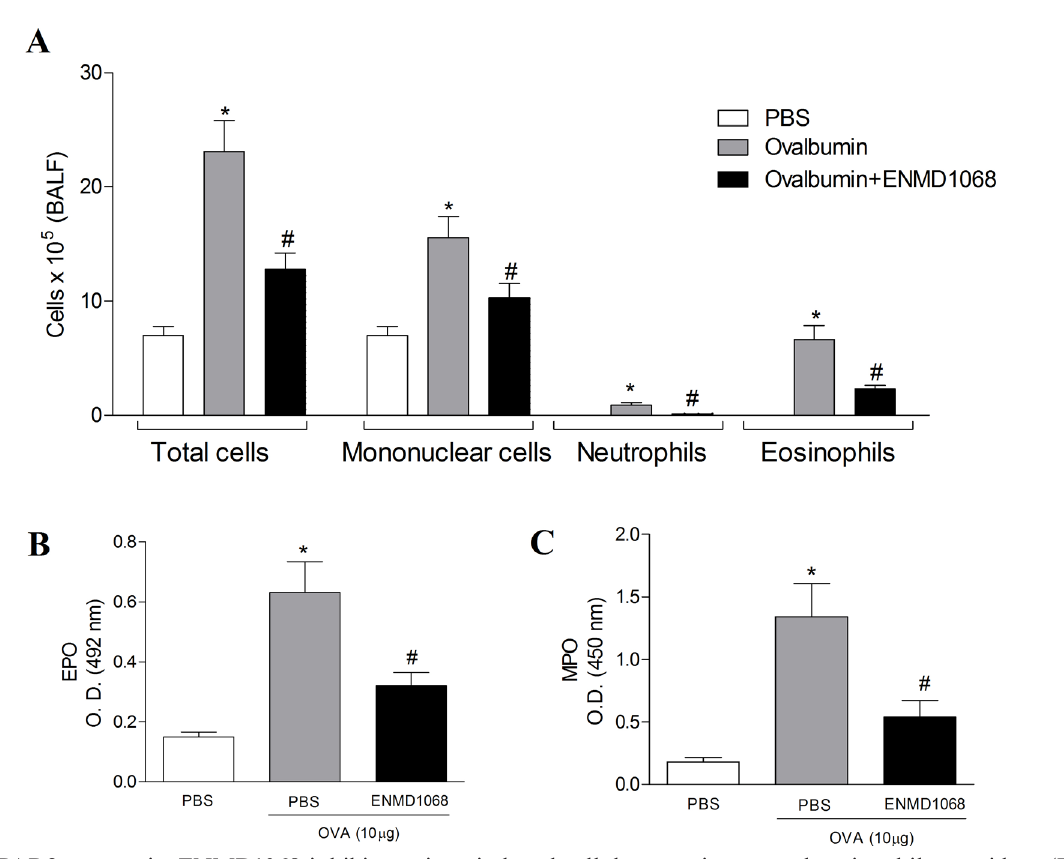
FIGURE 1 - PAR2 antagonist ENMD1068 inhibits antigen-induced cellular recruitment and eosinophil peroxidase (EPO) and myeloperoxidase (MPO) activity in the lungs of sensitized mice after multiple exposures to an antigen. Infiltrating leukocytes (A), EPO (B) and MPO (C) measurement in BALF 48 hours after the last intranasal allergen challenge in mice. The results are representative of 2 independent experiments and are expressed as the mean ± S.E.M. of n= 6-8 mice/group. *p<0.001 compared to the PBS group (white bar), #p<0.05:ENMD1068 group when compared to OVA group (ANOVA followed by the Student- Newman-Keuls